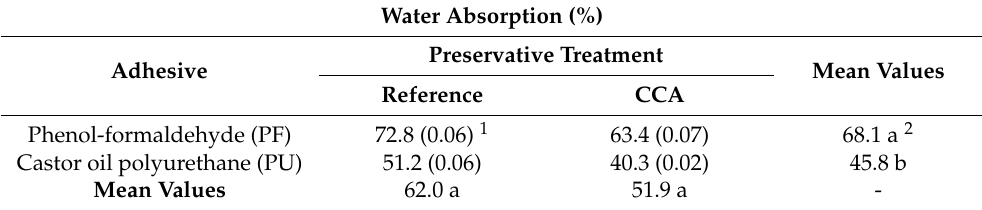
Table 6. Results: water